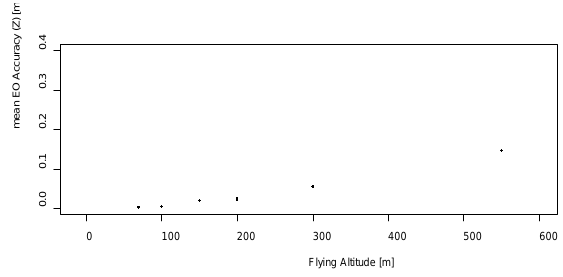
Figure 6. Mean EO accuracy for Z-component. Accuracy is decreasing with increasing flight altitude. The five remaining EO parameters behave similar